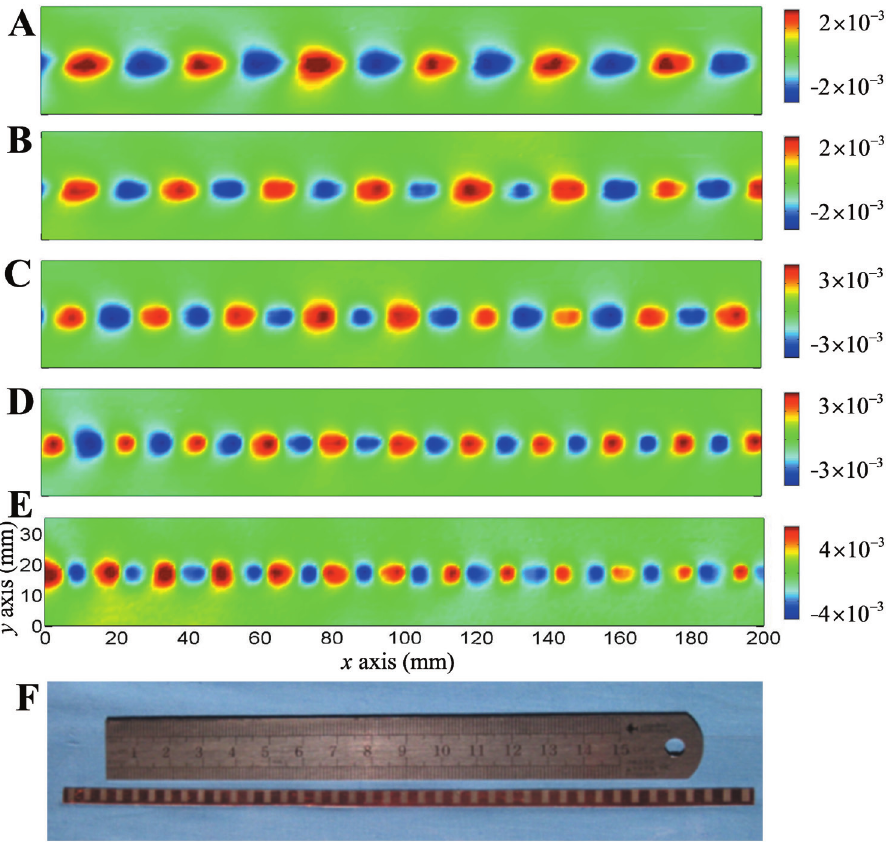
) of the planar plasmonic waveguide. (A) 7 GHz; (B) 8 GHz; (C) 9 GHz; (D) 10 GHz; (E) 11 GHz; (F) photo Figure 3: Measured electric field ( E z of fabricated planar plasmonic waveguide, in which the 0.018-mm-thick copper is printed on the 0.15-mm - thick substrate. The geometric parameters of groove are p = h = 5 mm, d = 4 mm, and a = 2 mm. Reproduced from [40] with